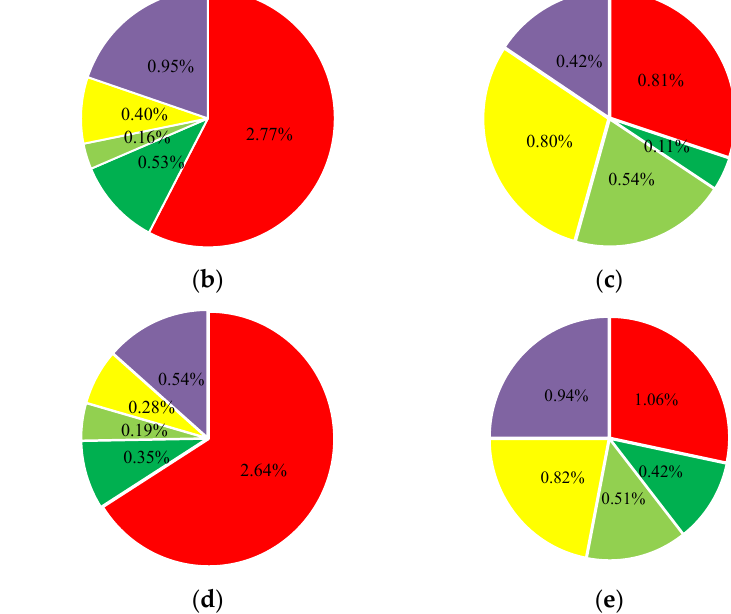
Figure 7. The area statistical analysis of image classification result. ( a ) Overall area proportion; ( b ) area proportion of b1; ( c ) area proportion of dk1; ( d ) area proportion of b2; and ( e ) area proportion of